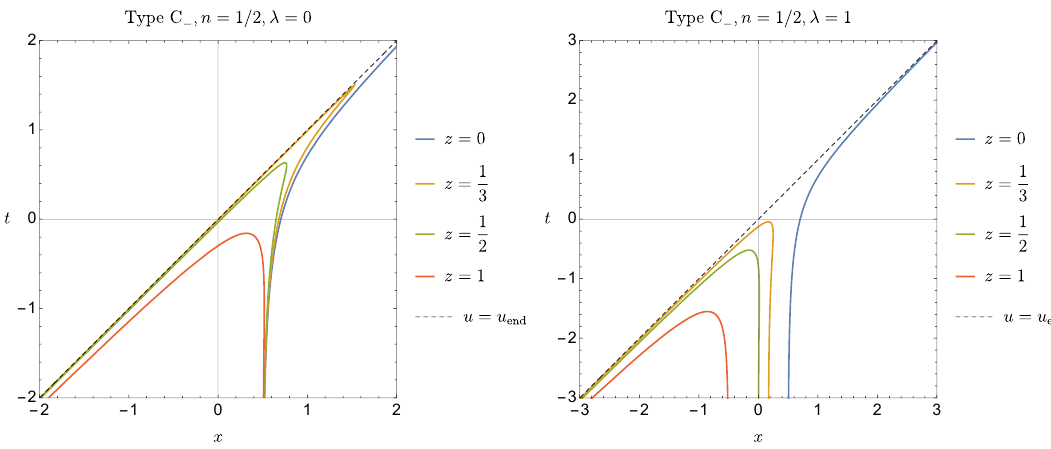
Figure 16 . The profiles of the brane Q associated with moving mirrors of type C − . The mapping functions are defined in eq. (4.5). We have set β = 1 , u